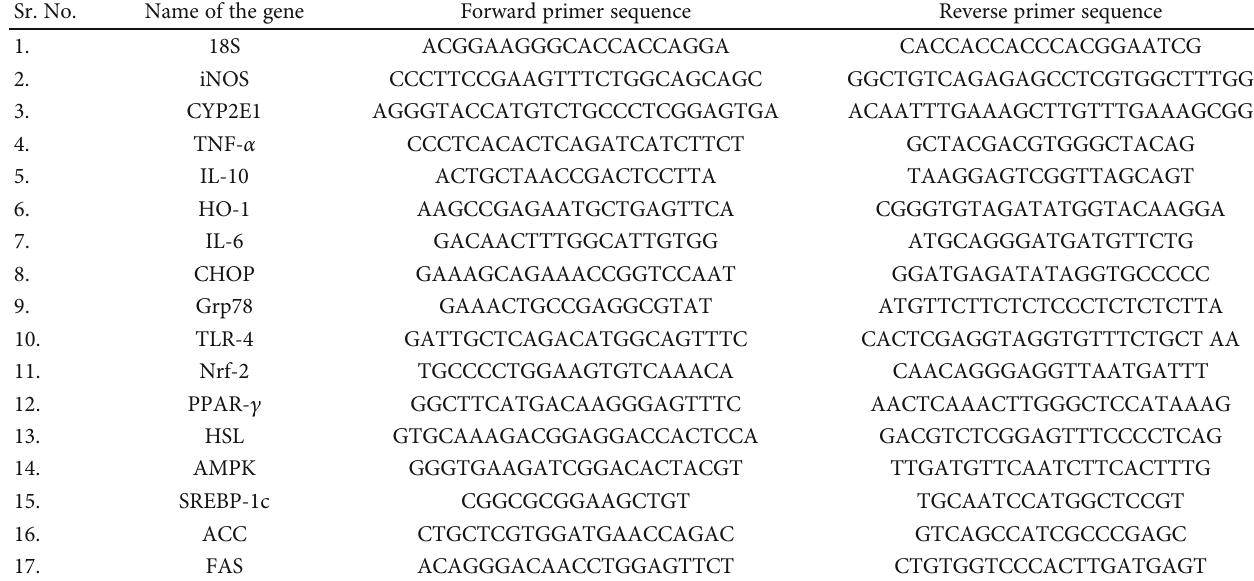
Table 1: The list of Homo sapiens primers used for quanti fi cation of mRNA expression levels in qRT-PCR. Sr.